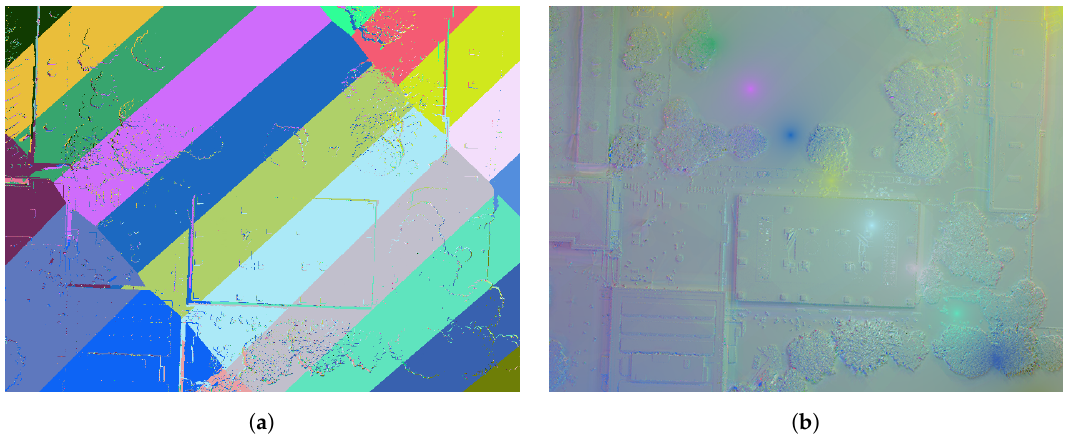
Figure 12. ( a ) Contribution of images to part of a true orthophoto generated using the closest visible image criteria, and ( b ) contribution of the same images in the inverse distance weighting (IDW)-based spectral balancing